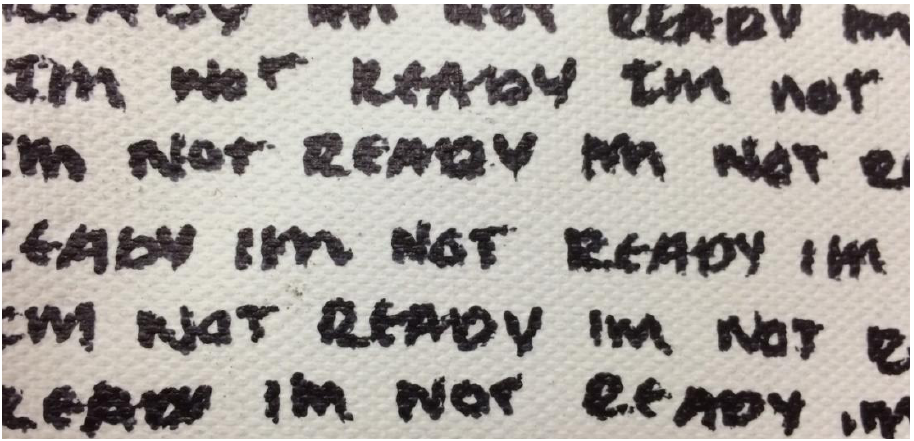
Figure 1. Thomas, J (2016). Undergraduate student feedback.